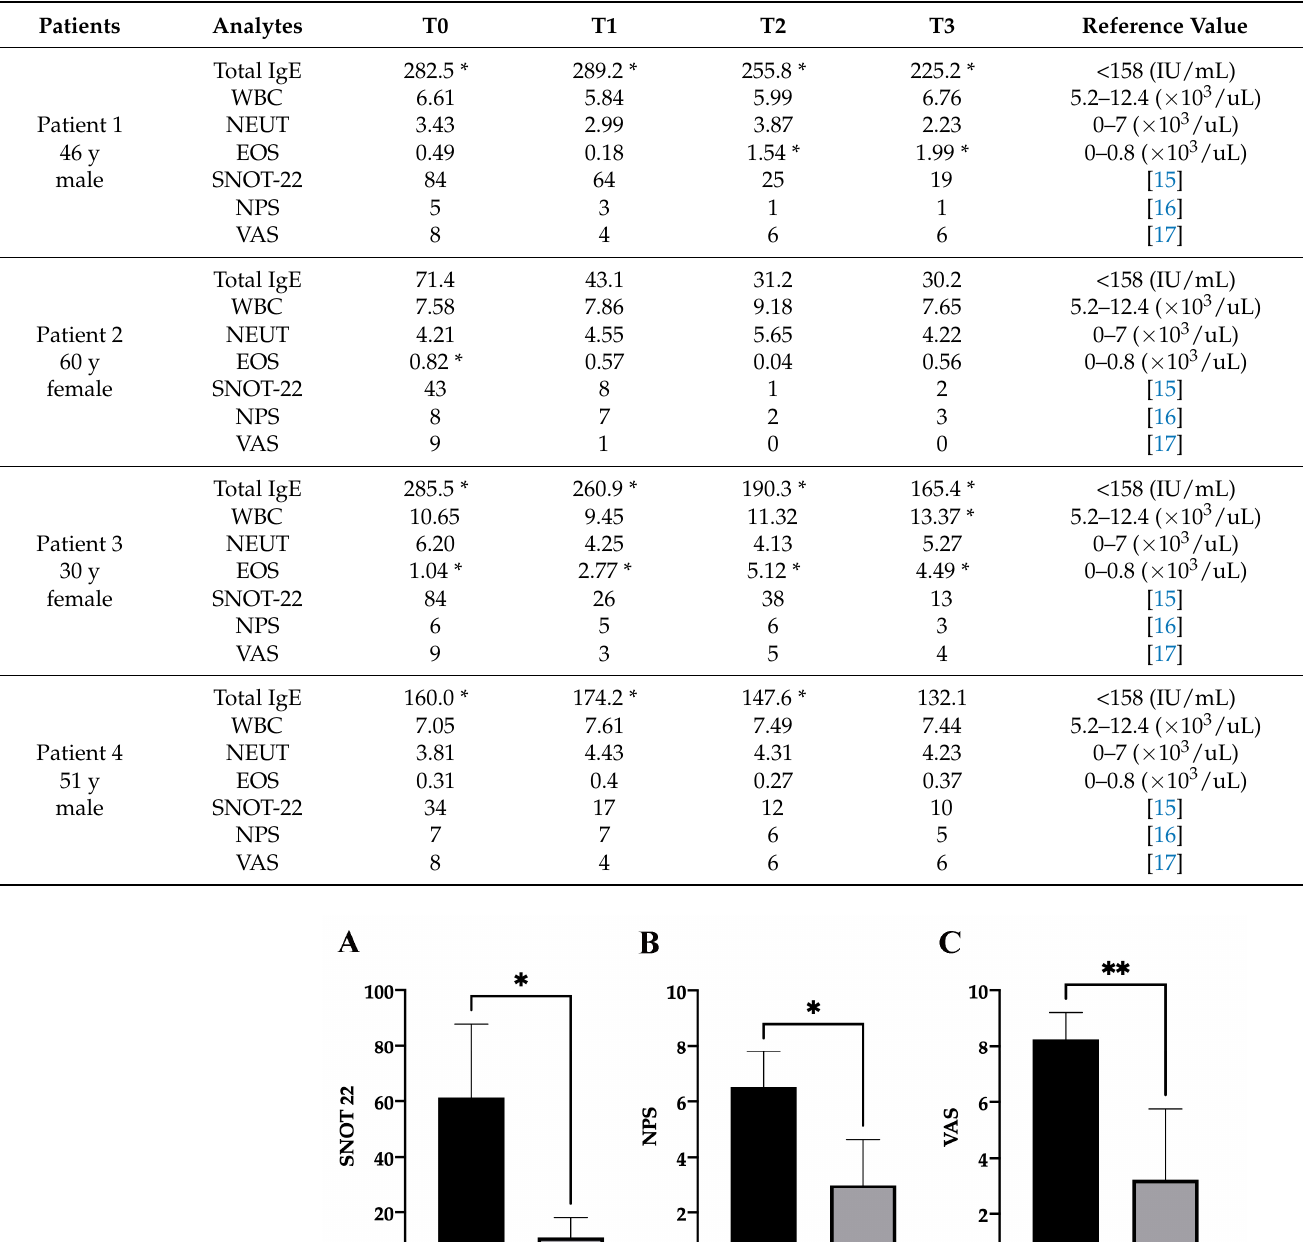
Table 1. Clinical and biochemical data of enrolled patients with CRSwNP diagnosis. Symbol (*) indicates outlier values. Values of white blood cells (WBC), neutrophils (NEUT), and eosinophils (EOS) were obtained from blood count reports.